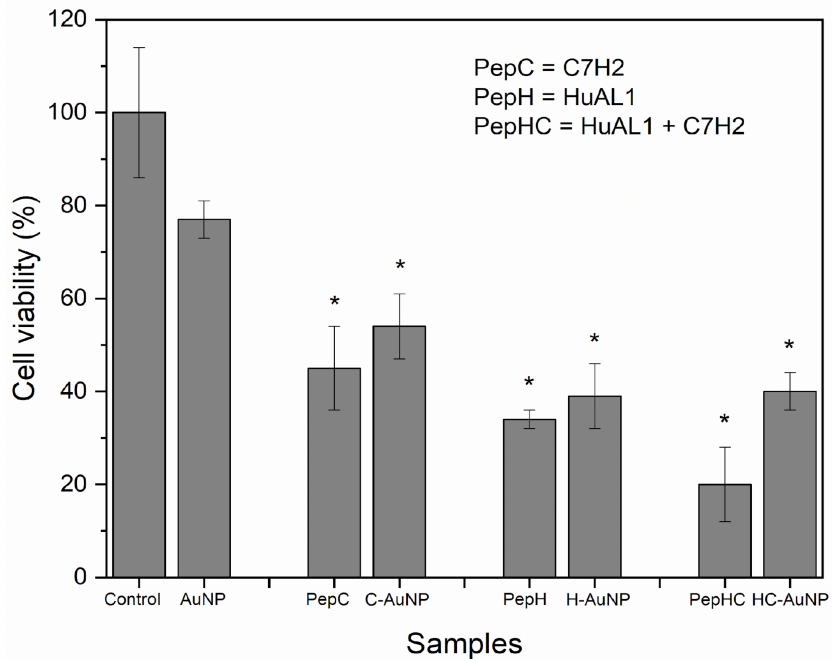
Figure 4. Viability of Hs68 cells incubated with AuNPs before and after conjugation with both peptides C7H2 and HuAL1, individually (C-AuNP and H-AuNP) or combined (HC-AuNP). The cells were also incubated with the peptides free in solution. Values are depicted as mean values and standard deviation ( n = 3) (* p -value <